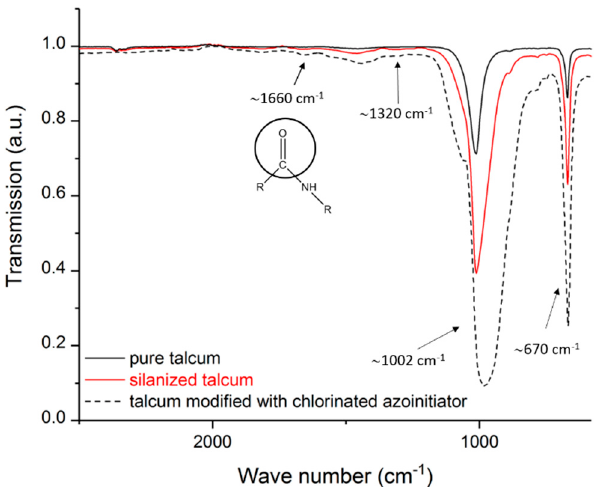
Figure 2. Infrared spectroscopy of pure, silanized and talcum modified with chlorinated azoinitiator.